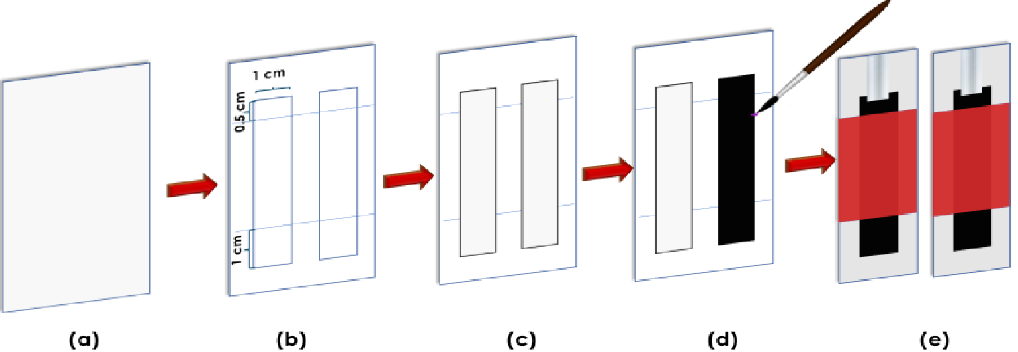
Figure 1. The scheme of screen printing of the proposed sensors. ( a ) Transparent recycled X-ray sheet; ( b ) a pattern printed on a self-adhesive stencil sheet placed on the recycled X-ray sheet marking a defined square-shaped (10 mm × 10 mm) working area for applying the ion-sensing cocktail and a rectangular area (10 mm × 5 mm) on the other side for electrical contact using silver paint; ( c ) the electrode region determined by the cut pattern; ( d ) careful painting of conducting ink on the delimited surface using a suitable brush and ( e ) peeling off the self-adhesive stencil from the X-ray sheet followed by placing a layer of an insulator onto the printed electrodes and applying silver paint for electrical contact.